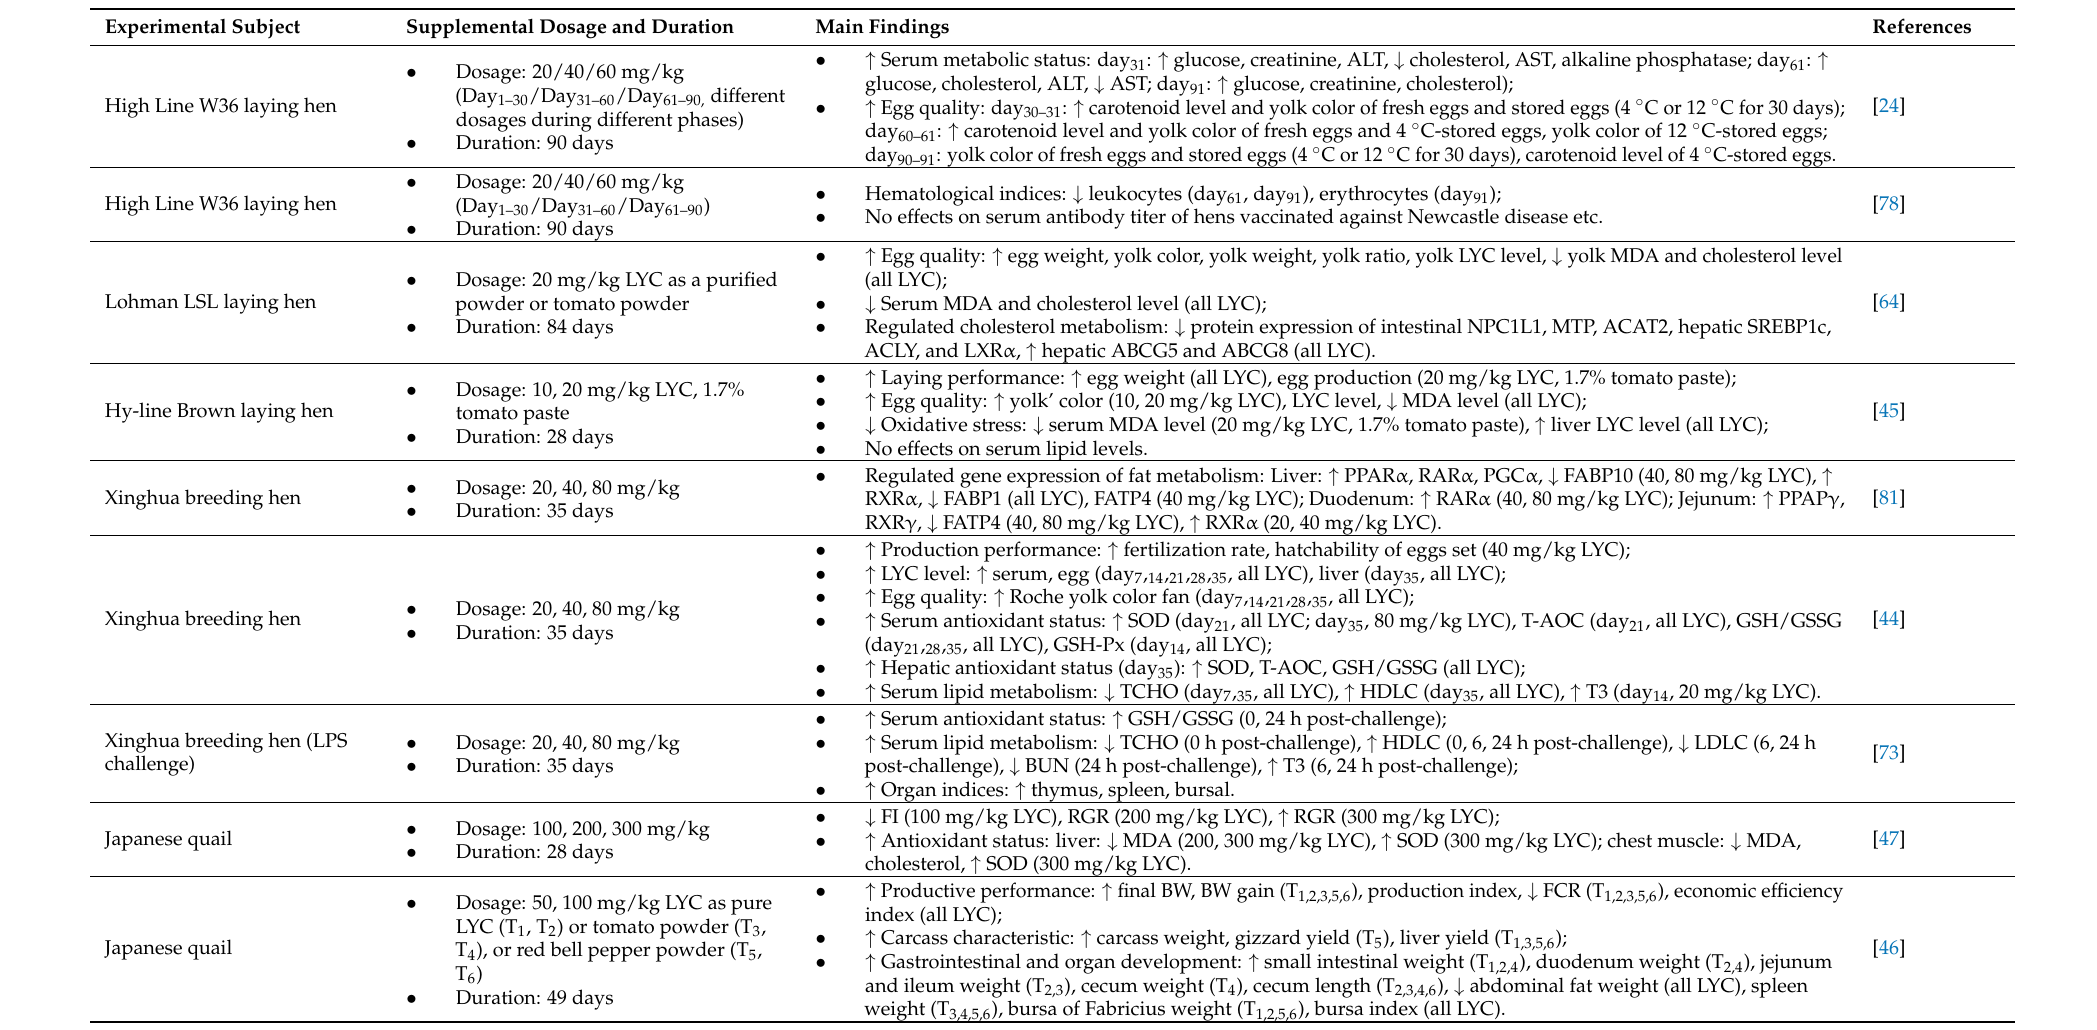
Table 3. The summary of lycopene (LYC) as a functional feed additive for egg-producing poultry during the past decade